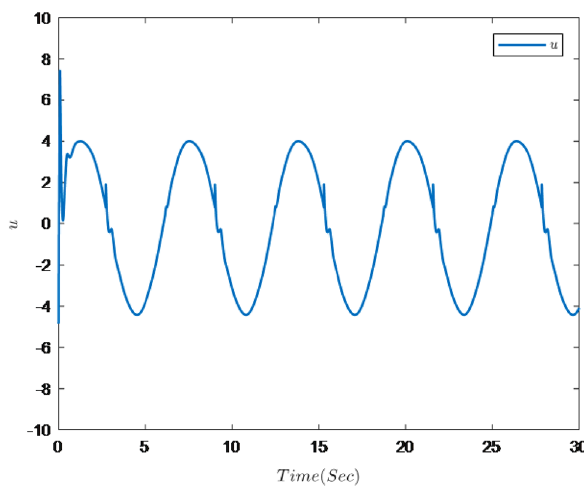
Figure 11. Trajectory of the system input u